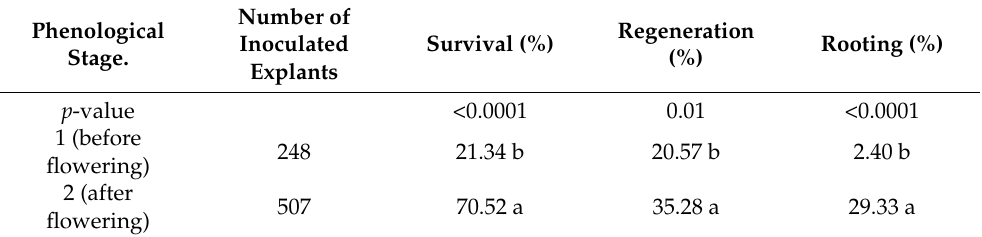
Table 3. Effect of the phenological stage on the growth and development of in vitro meristem culture.